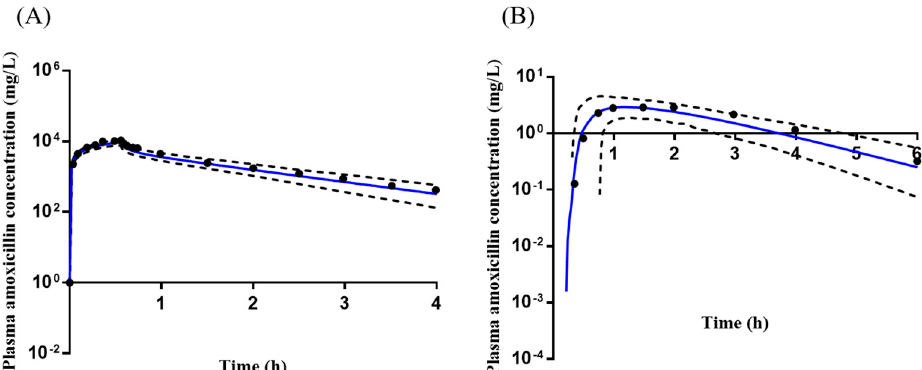
Figure 2. The mean observed (black dot) and predicted (solid blue line, n = 100) plasma concentration–time profiles of amoxicillin. ( A ) Administration of a single 250 mg capsule, observed n = 7 [23]; ( B ) administration of a single 259.6 mg tablet, observed n = 10 [23]. The black dotted and solid lines represent the 5th and 95th percentiles. The observed data were adapted from a reference [23].